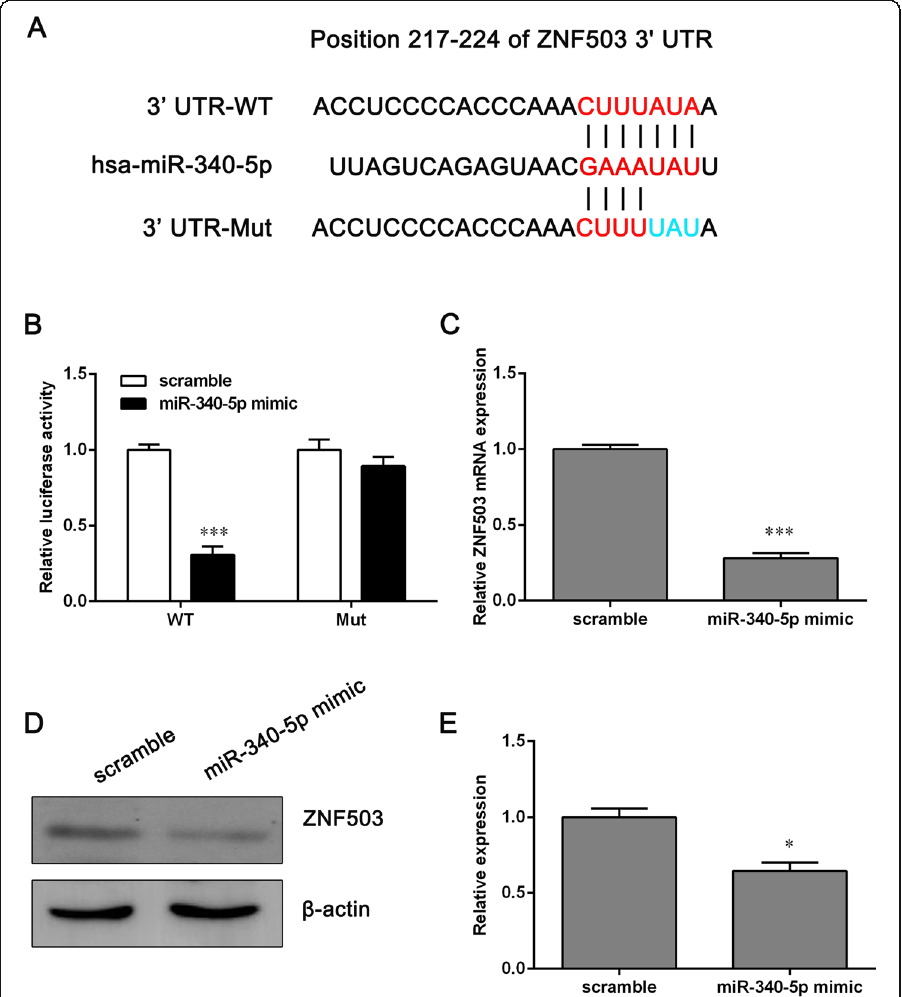
was used to evaluate the binding specificity between miR-340-5p and WT-3 ′ -UTR-ZNF503. c The mRNA level of ZNF503 in NCI-H1650 cells transfected with miR-340-5p mimics was determined using a qPCR assay. d The expression of ZNF503 protein was determined via western blotting after NCI-H1650 cells were transfected with miR-340-5p mimics. e The relative protein expression is shown. Data are expressed as the means ± SD ( n = 3). * p < 0.05 and ** p < 0.001 versus the scrambled